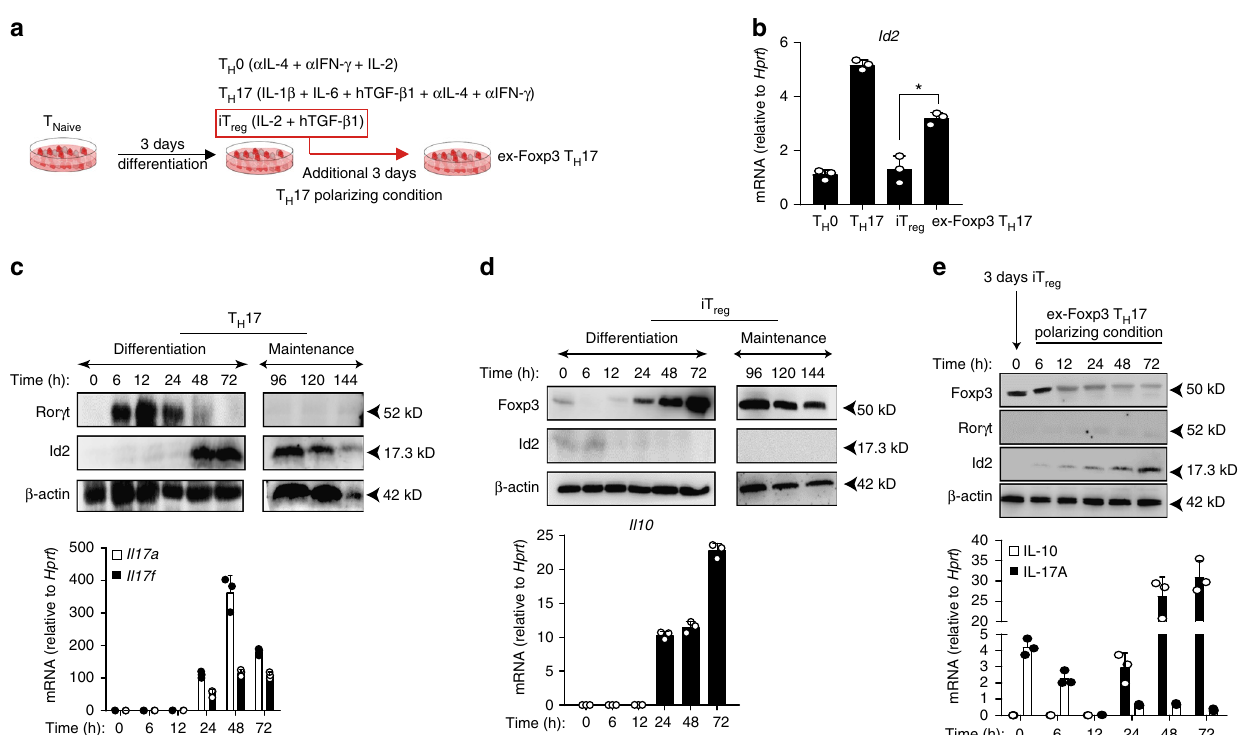
Fig. 1 Id2 expression is enhanced during a conversion to T H 17 phenotype from iT reg cells. a In vitro polarization scheme of T H 0, T H 17, iT reg and ex-Foxp3 T H 17 cells. b RT-qPCR analysis of Id2 mRNA in in vitro generated T H 0, T H 17, iT reg and ex-Foxp3 T H 17 cells; results are presented relative to Hprt expression ( n = 3) c , d Western blot analysis to determine the kinetics of indicated proteins during T H 17 ( c , top panel) and iT reg ( d , top panel) cell differentiation